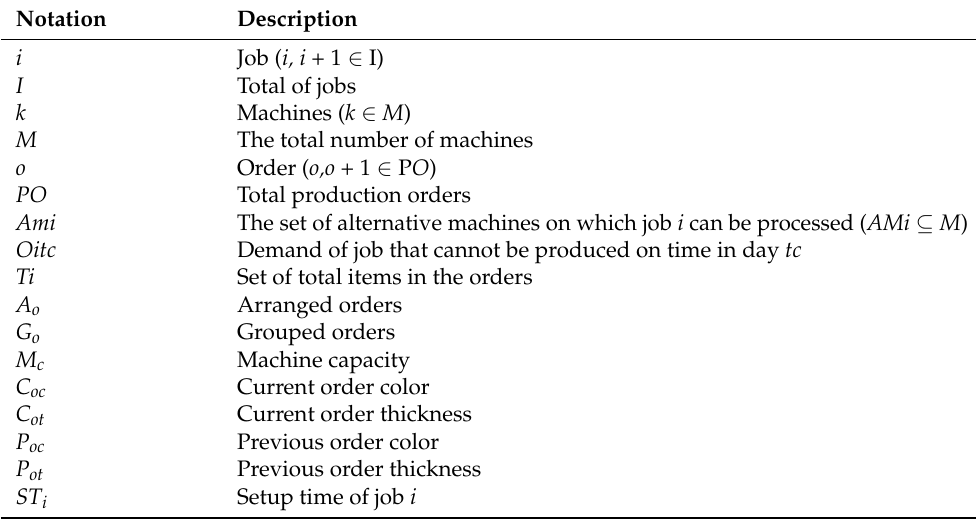
Table 3. Description of production-line notation.